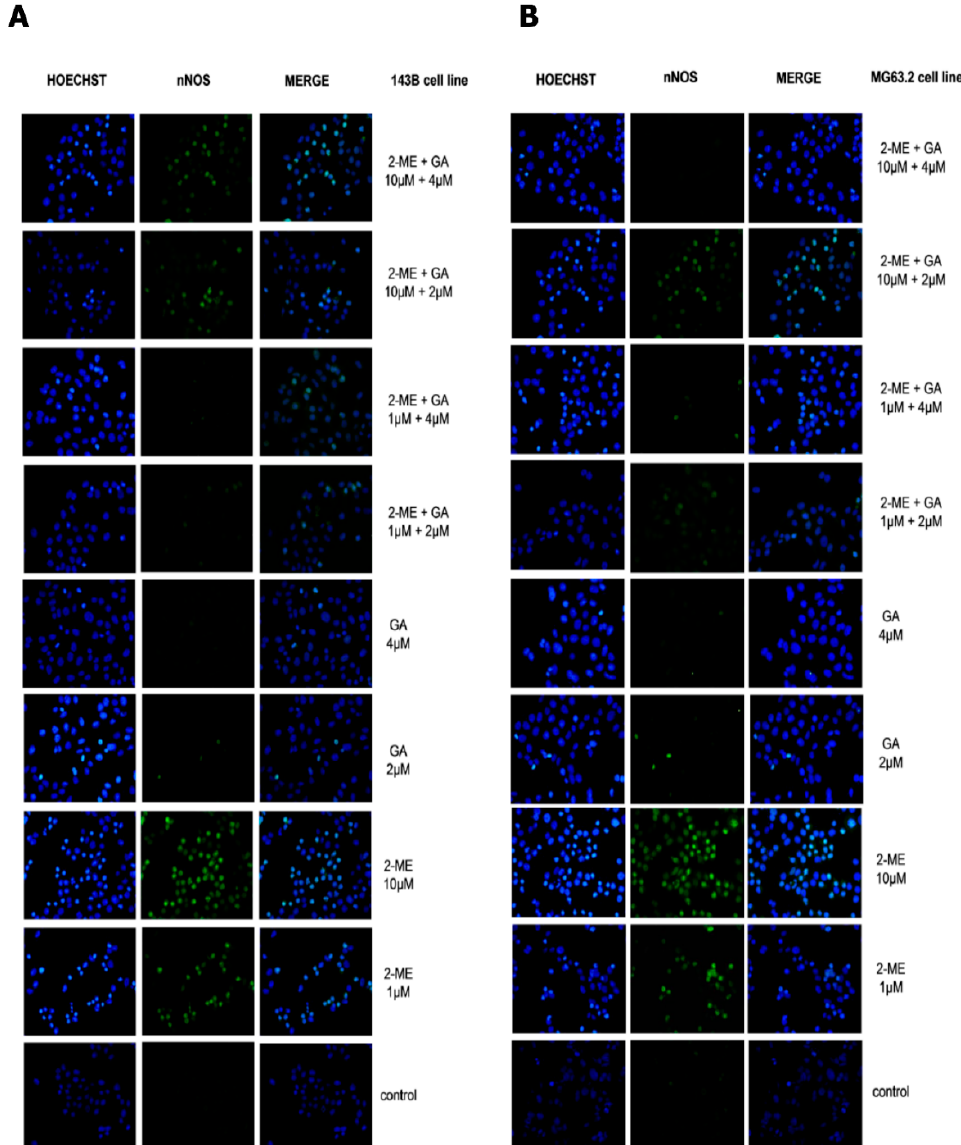
Figure 4. GA abrogates stimulatory effect of 2-ME on nNOS expression and nuclear translocation in 143B and MG63.2 cell lines. nNOS protein level in OS 143B and MG63.2 cells treated with vehiculum (Control) or either 2-ME or GA, or a combination of both compounds. OS 143B cells ( A ) and MG63.2 ( B ) were treated for with either 2-ME (1 µ M or 10 µ M) or GA (2 µ M or 4 µ M), or a combination of both for 8 h. The nNOS protein level was then determined by immunofluorescence. Cell nuclei were shown in blue, nNOS immunoreactivity in green, merged images of both in light blue. Original magnification × 40. Each experiment was performed at least three times. The representative data are shown. Notably, 1 µ M and 10 µ M 2-ME resulted in 1.5-, and 4-fold increase in the level of nNOS protein in 143B cells, while in 2.1 and 3.3-fold change in MG63.2 cells, respectively (Figure 2). GA alone